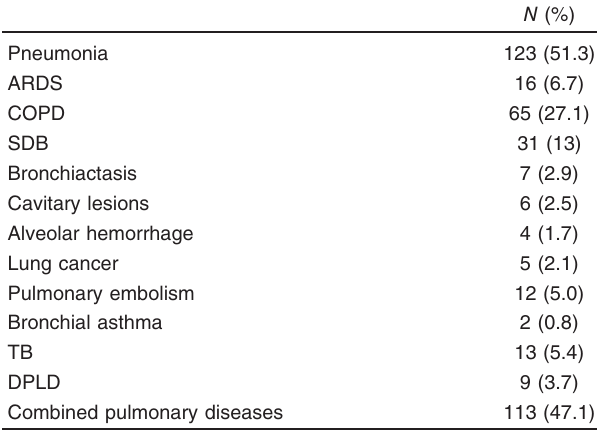
Table 1 Primary diagnosis of ventilated patients